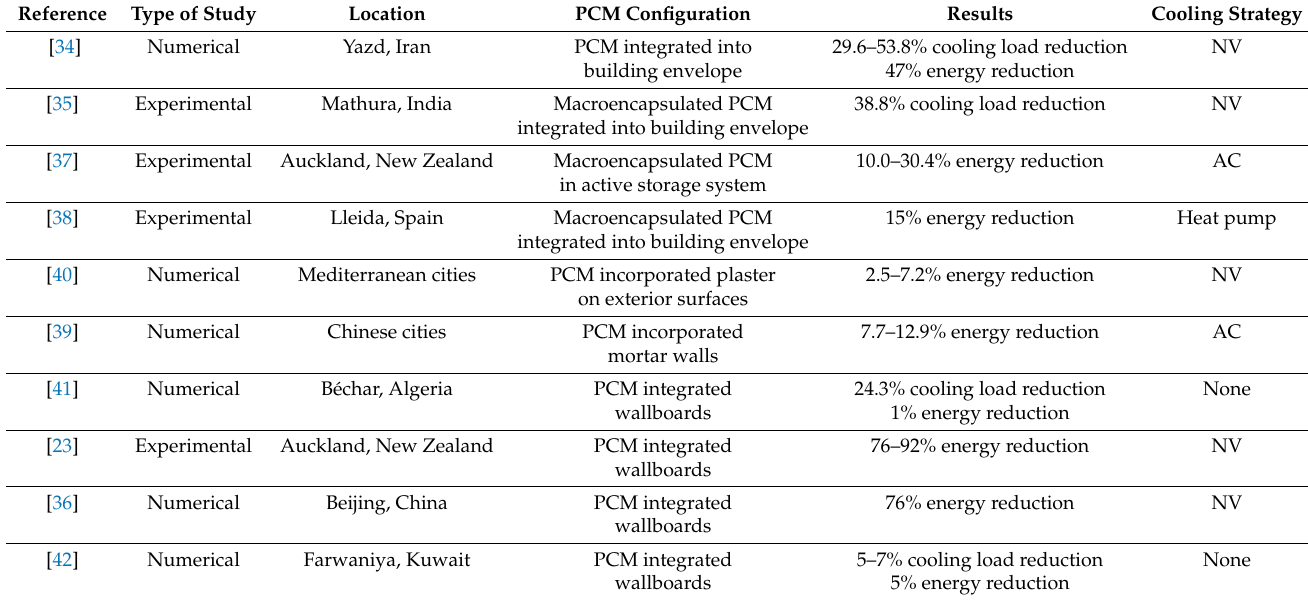
Table 1. PCM’s impact on cooling